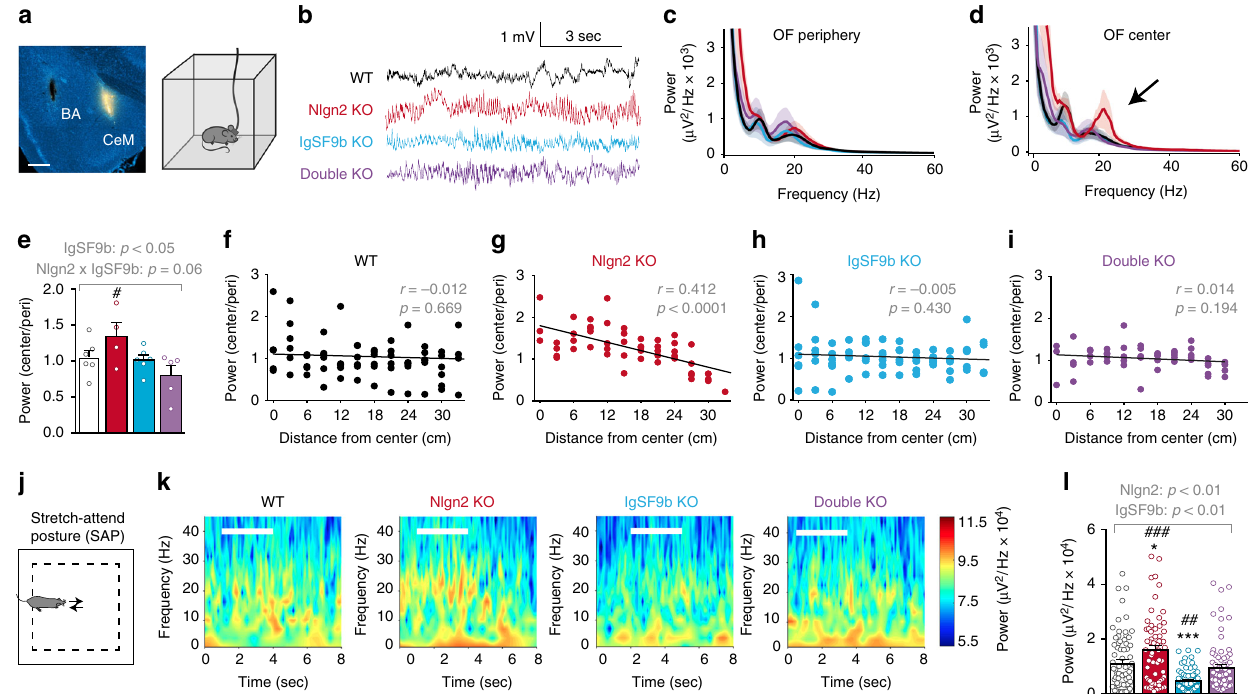
Fig. 3 Neuronal activity in the beta frequency range is normalized in the CeM of double KO mice. a Representative image of the location of electrode in the CeM and experimental design. Scale bar, 500 µ m. After electrode implantation mice were exposed to the OF for 15 min. b Representative traces of CeM LFPs from all four genotypes during SAP. c , d LFP power spectrum for all four genotypes during movement in the periphery ( c ) and center ( d ) of the OF. e Average power increase in the center relative to the periphery of the OF for the beta frequency range (18 – 30 Hz). f – i Increase in normalized beta power as a function of distance from the center in WT ( f ), Nlgn2 KO ( g ), IgSF9b KO ( h ), and double KO ( i ) mice. Statistical analysis of correlations is indicated in the fi gure. j Schematic of the stretch-attend posture (SAP) scored during the OF test. k Representative wavelet transforms of CeM LFP of the four genotypes during exploration of the OF. White horizontal lines indicate the duration of a representative SAP. l Average beta power during SAP. Statistically signi fi cant ANOVA comparisons are marked in gray at the top of the panels and are listed in Table 1. For all other ANOVA comparisons, F < 1. Post-hoc analysis: * p < 0.05 relative to WT, *** p < 0.001 relative to WT, # p < 0.05 relative to double KO, ## p < 0.01 relative to double KO, ### p < 0.001 relative to double KO. SAPs and mice: WT n = 77/ 6 mice; Nlgn2 KO n = 62/ 5 mice; IgSF9b KO n = 84/ 6 mice; double KO n = 71/ 5 mice. Error bars represent SEM. WT, white bars; Nlgn2 KO, red bars; IgSF9b KO, blue bars; double KO, purple